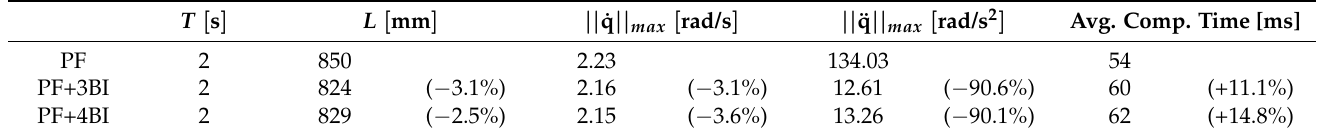
Table 2. Results from simulations of Example